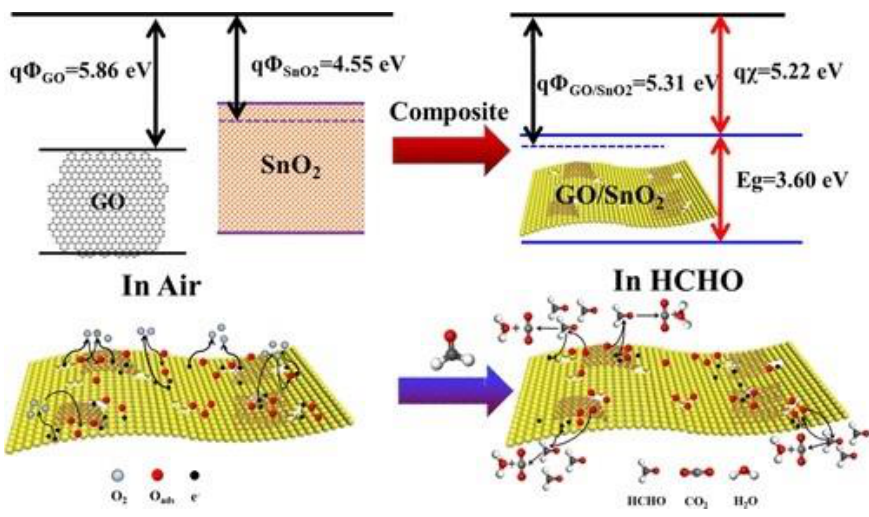
Figure 14. Schematic diagram of the sensing mechanism [46].